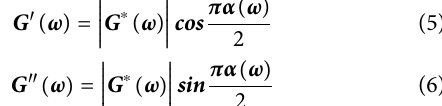
Frontiers in Bioengineering and Biotechnology |